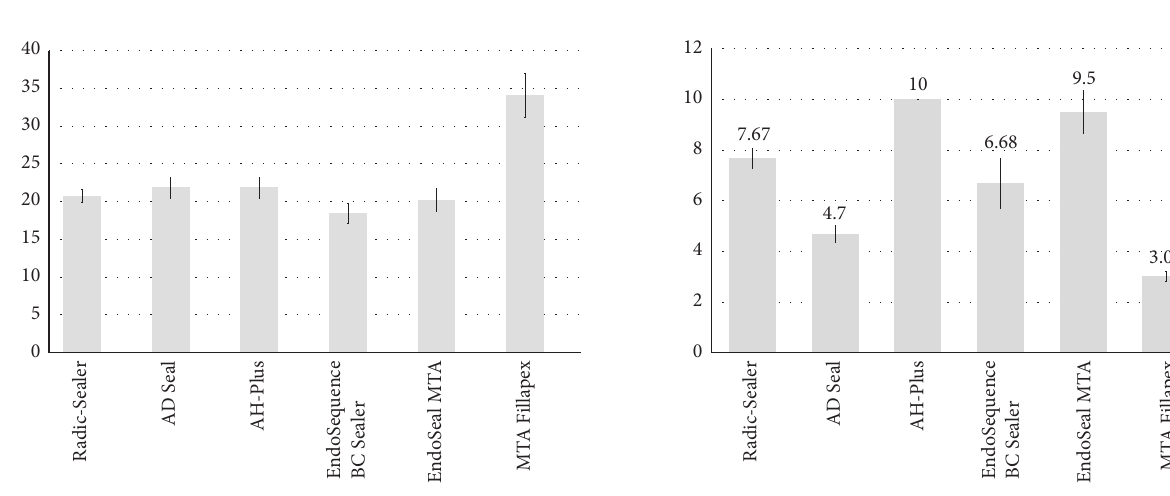
Figure3:Radiopacityvaluesfromeachsealerevaluated(inmm Al). a , b , c , d , e Different letters present significant difference between groups ( 𝑃 < 0.05